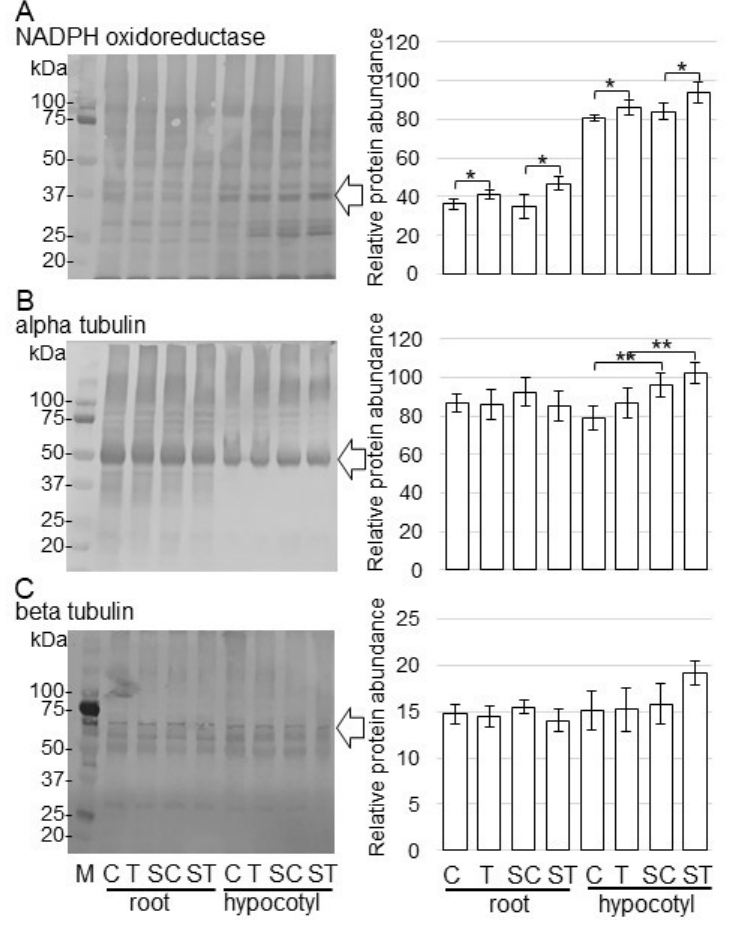
Figure 5. Accumulation of NADPH oxidoreductase and tubulins in root and hypocotyl of soybean treated with ZnO NPs. Proteins (10 µg) extracted from root and hypocotyl of soybean treated with or without ZnO NPs in solution and BL-fiber, separated on SDS-polyacrylamide gel, and transferred onto membranes. The membranes were cross-reacted with anti-NADPH oxidoreductase ( A ), anti- alpha tubulin ( B ), and anti-beta tubulin ( C ) antibodies. Coomassie brilliant blue pattern was used as a loading control (Figure S2). The integrated densities of bands were calculated using ImageJ software. Data are presented as the mean ± S.D. from three independent biological replicates (Figures S3–S5). Asterisks indicate significant changes between the two treatments according to Student’s t -test (** p < 0.01; * p < 0.05).